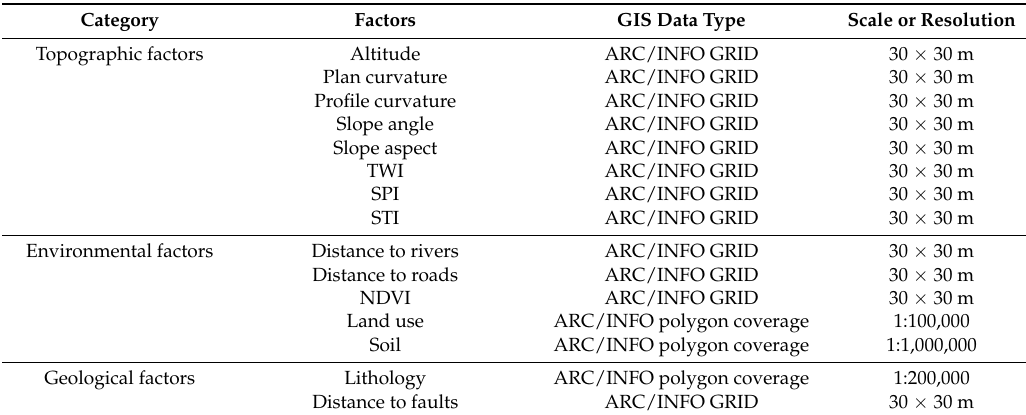
Table 1. Landslide conditioning